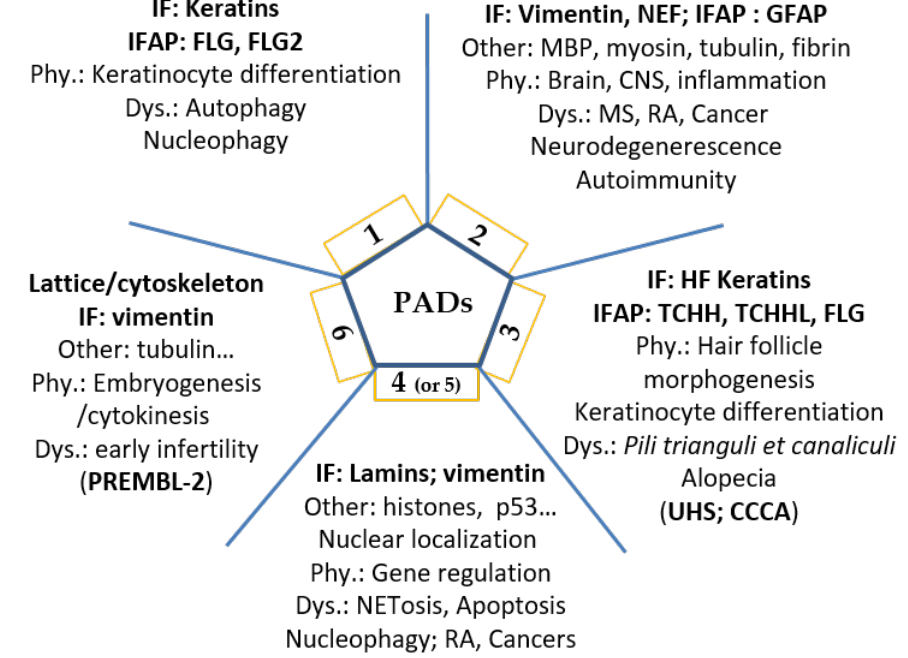
Figure 4. Schematic representation of the major involvements of PADs.